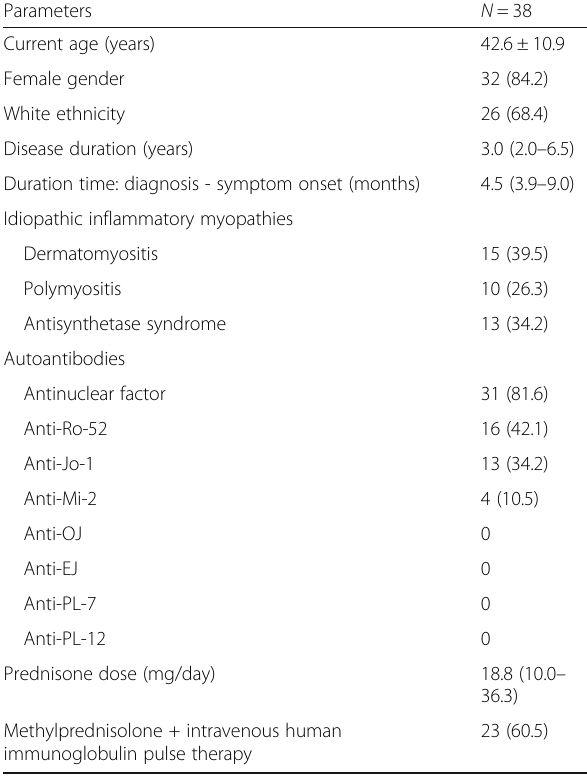
Table 1 Demographic features, types of idiopathic inflammatory myopathies, autoantibody distribution and therapy of 38 patients immediately before rituximab application